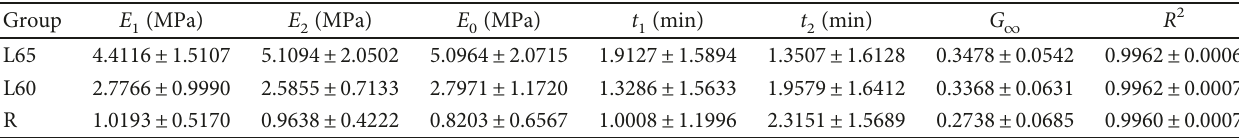
Table 5: The fi tted parameters of stress-relaxation data by model